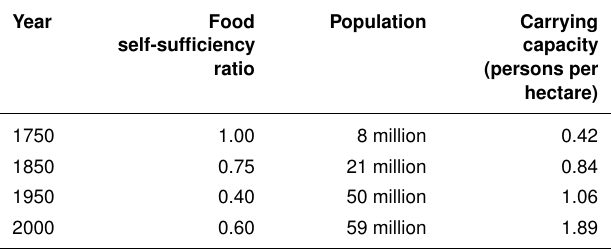
Table 1. Estimates of UK farmland carrying capacity in 1750, 1850, 1950 and